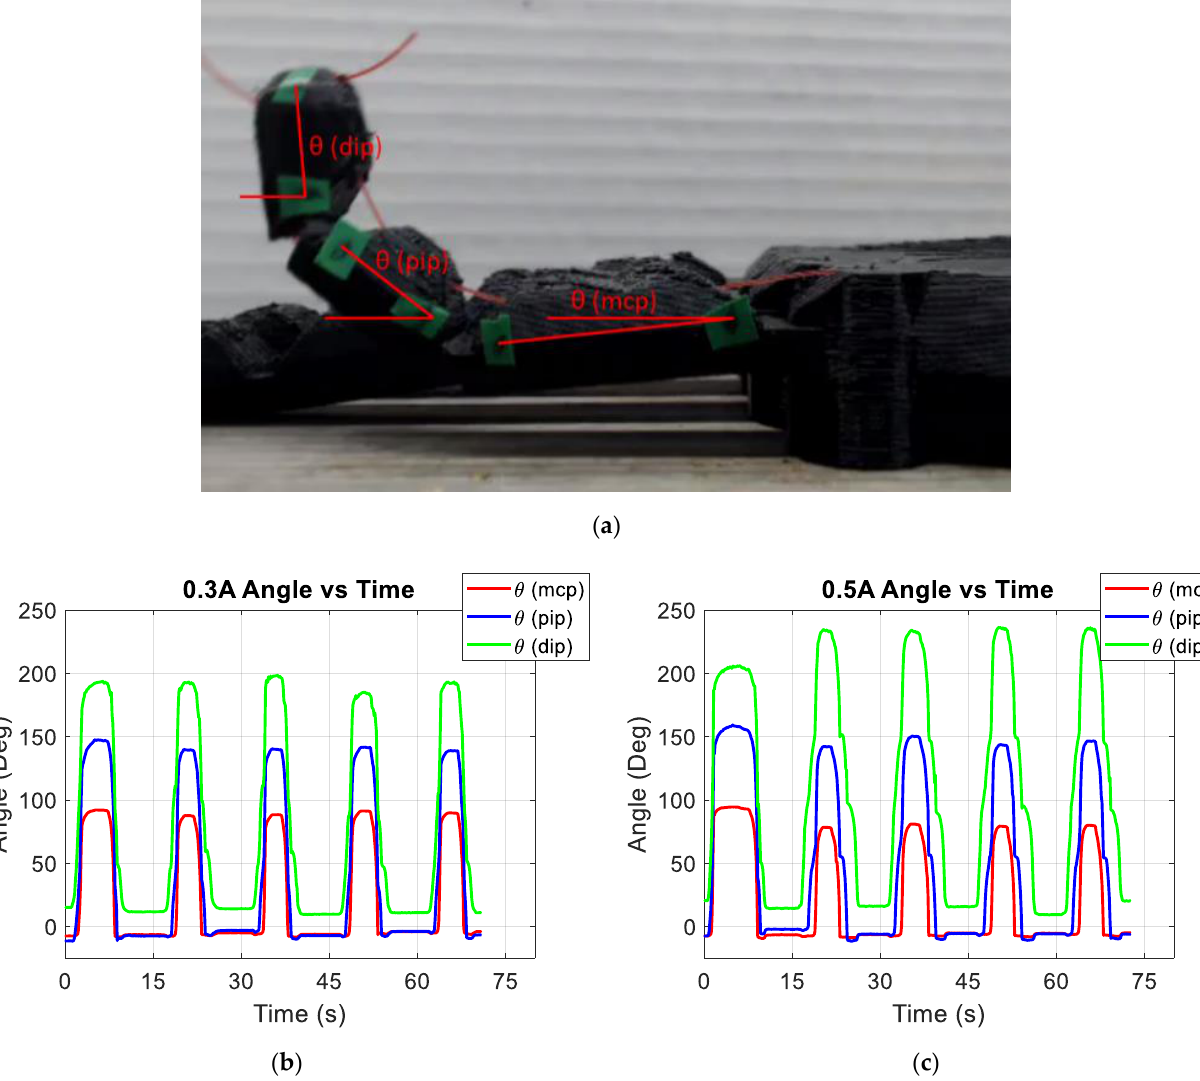
Figure 8. Single finger testing: ( a ) diagram of θ (as measured from horizontal plane); ( b ) actuation angles for 0.3 A cycles and ( c ) angles for 0.5 A cycles. The heating cycle applied was 0.3/0.5 A to the flexor for 5 s, then the same amount to the extensor for 10 s. The period of actuation is thus 15 s.